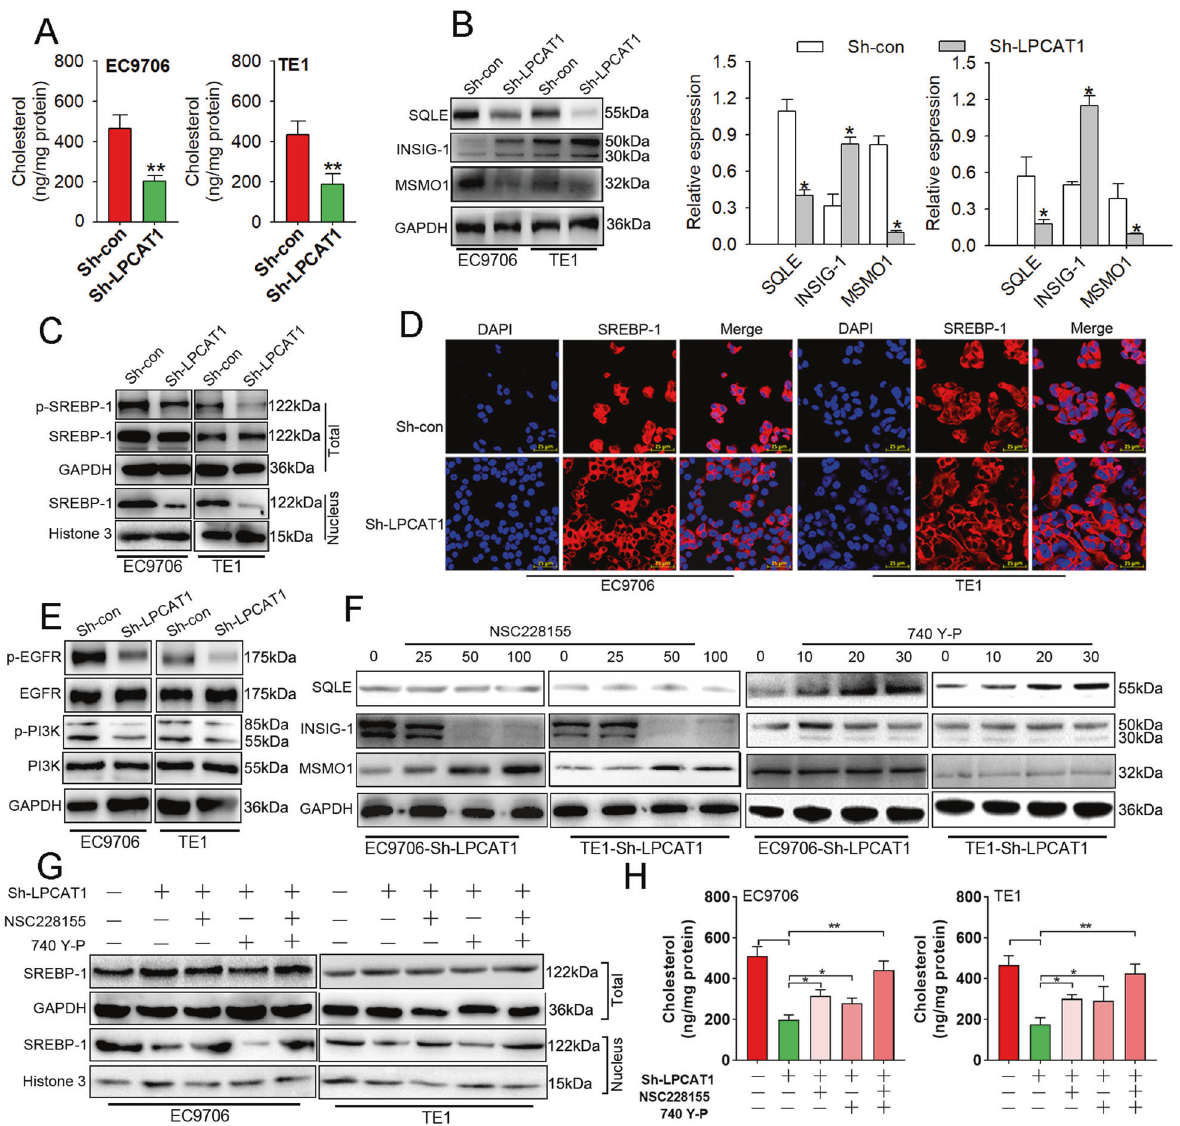
Fig. 5 LPCAT1 promote ESCC cholesterol synthesis by EGFR/INSIG-1/SREBP-1 pathway. A The level of cholesterol in EC9706 and TE1 cells transfected with sh-control and sh-LPCAT1 was detected using the cholesterol detection kit. B The expression of SQLE, Insig-1, and MSMO1 in EC9706 and TE1 cells transfected with sh-control and sh-LPCAT1 was detected using western blot. C , D The expression of p-SREBP-1 in the nucleus in EC9706 and TE1 cells transfected with sh-control and sh-LPCAT1 was detected using western blot and immuno fl uorescence. E The expression of p-EGFR and p-PI3K in EC9706 and TE1 cells transfected with sh-control and sh-LPCAT1 was detected using western blot. F The expression of SQLE, Insig-1, and MSMO1 in EC9706 and TE1 cells treated with NSC228155 or 740Y-P after transfection with sh-LPCAT1 was detected using western blot. G The expression of p-SREBP-1 in the nucleus in EC9706 and TE1 cells treated with NSC228155 or 740Y-P after transfection with or without sh-LPCAT1 was detected using western blot. H The level of cholesterol in EC9706 and TE1 cells treated with NSC228155 or 740Y-P after transfection with or without sh-LPCAT1 was detected using the cholesterol detection kit. Data represent three independent experiments. * P < 0.05, ** P < 0.01 (unpaired t test, one-way ANOVA). Data are from three independent